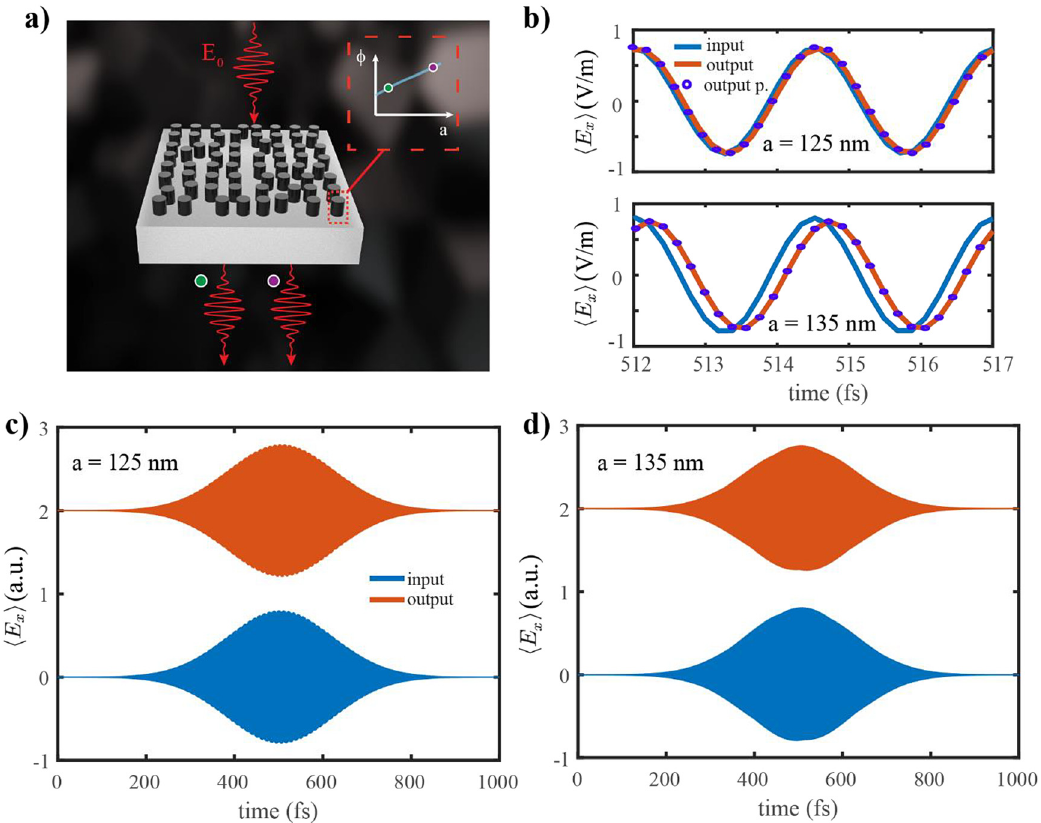
Figure 7: Manipulating the phase of an x -polarized fs Gaussian pulse with a disordered HA metasurface on a semi-in fi nite glass substrate. (a) Artistic representation of the concept, depicting the impinging and outgoing pulses from the disordered HA metasurface with tailored nanoparticlesizes,andaschematicofthelookuptable.(b)Transparencyandadvancedphaseoftheoutputpulseattheirmaxima,for a =125, 135 nm (top and bottom panels, respectively) in the disordered lattice, in perfect agreement with the periodic arrangement (output p .). The height of the nanorods is kept constant at 370 nm. (c and d) Temporal pro fi les of the incoming (input) and outgoing pulses (output), demonstrating full transmission for the two cases studied. In panels (b) – (d) the operator ‘ 〈〉 ’ denotes averaging over the transverse cross- section of a single unit